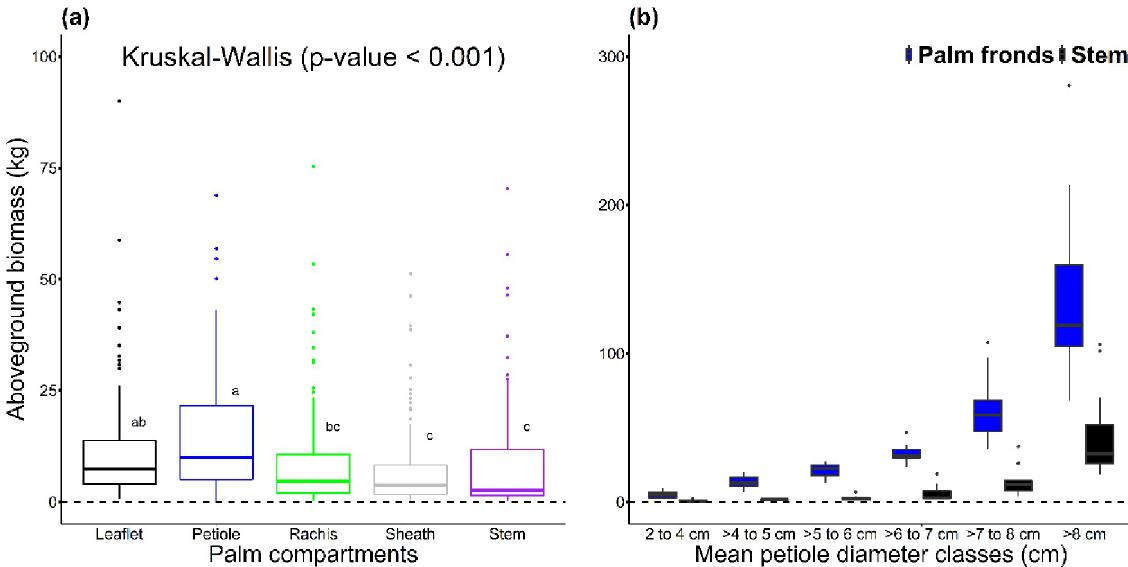
Fig 2. Variability of aboveground biomass between leaflets, petiole, rachis, sheath and stem, and the results of a Kruskal-Wallis test (a) and between palm frond compartments collectively and stem across mean petiole diameter classes (b) for the 90 Raphia laurentii individuals destructively